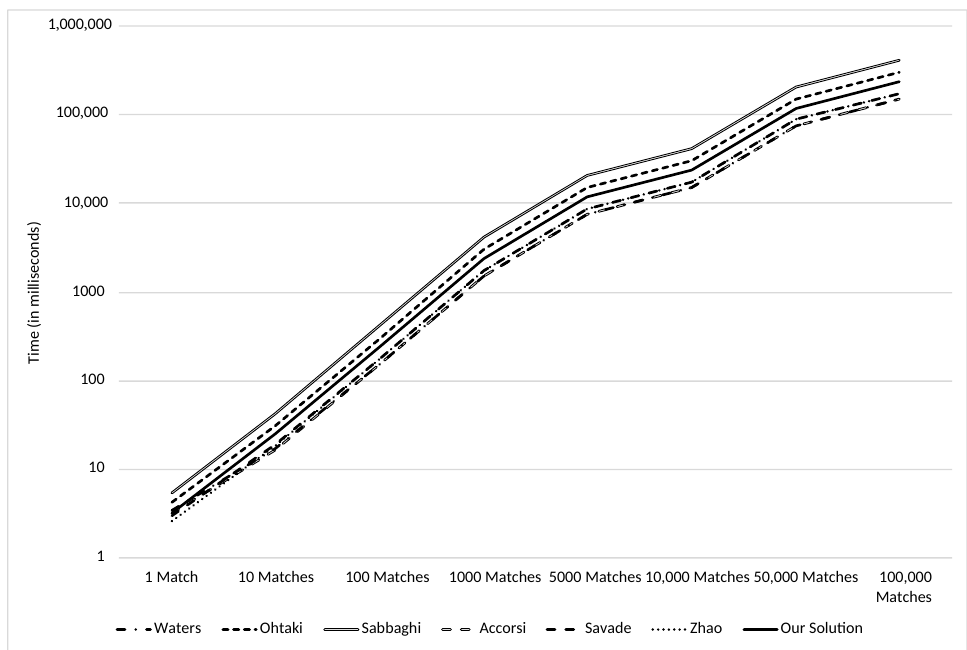
Figure 8. Comparison of searching